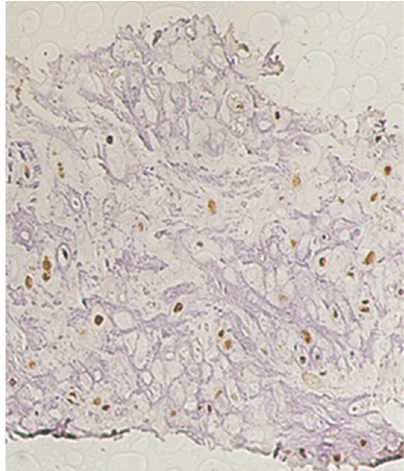
Figure 8. Immunostaining findings in patient 2. Immunostaining with labeled anti-Gli1 antibody. These findings are similar to those in patient